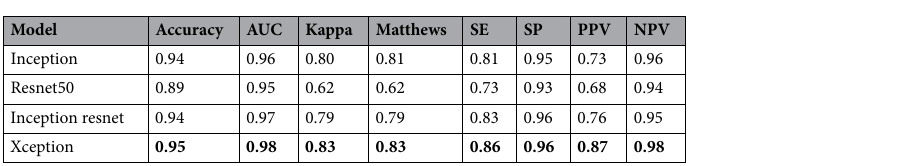
Table 1. Performance metrics for each of the